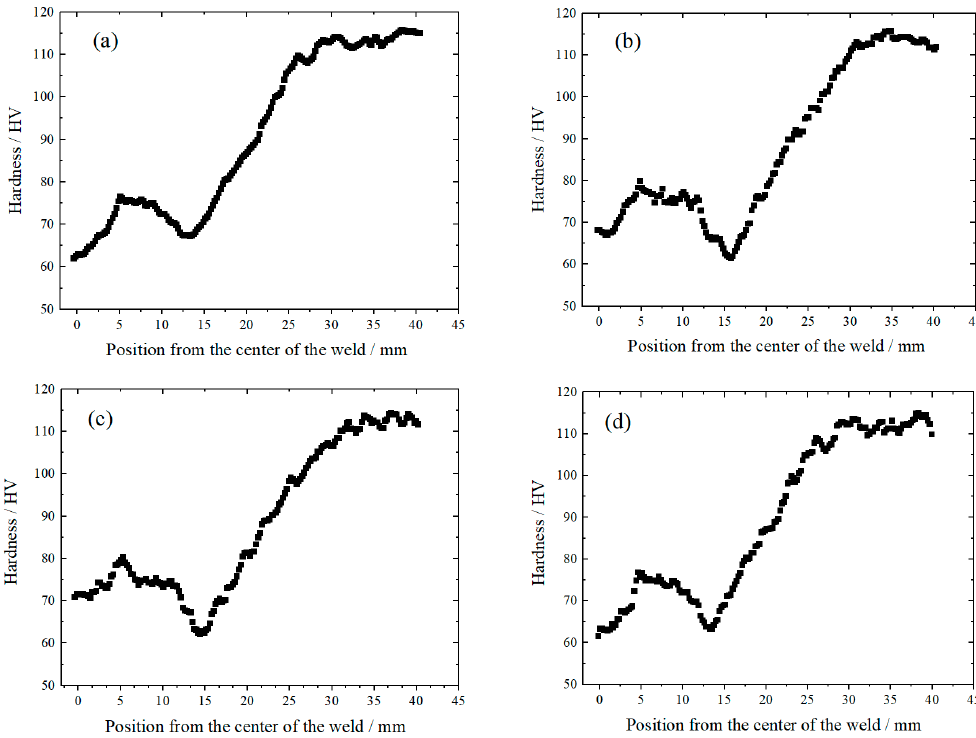
Figure 11. Hardness distribution under different welding conditions: ( a ) normal pulse; ( b ) double pulse, 1 Hz; ( c ) double pulse, 3 Hz; and ( d ) double pulse, 5 Hz.